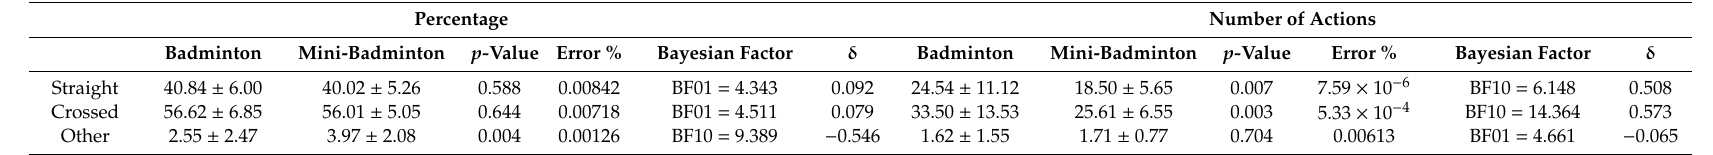
Table 7. Bayesian analysis of usage percentage and stock count technical and tactical in accordance with shuttle flight.